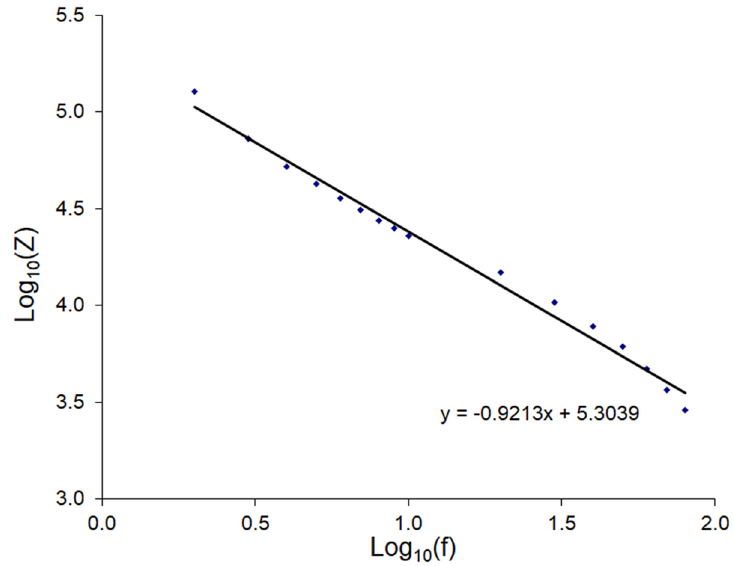
Figure 6. Dependence of the logarithm of the displacement of the impedance at the “zero length” of the sample on the logarithm of the frequency with linear regression. Table 2. Slope and offset of the linear function obtained by approximating the dependence of the impedance modulus on the sample length and capacitance formed by electrode connection points and non-conductive layers of the sample.